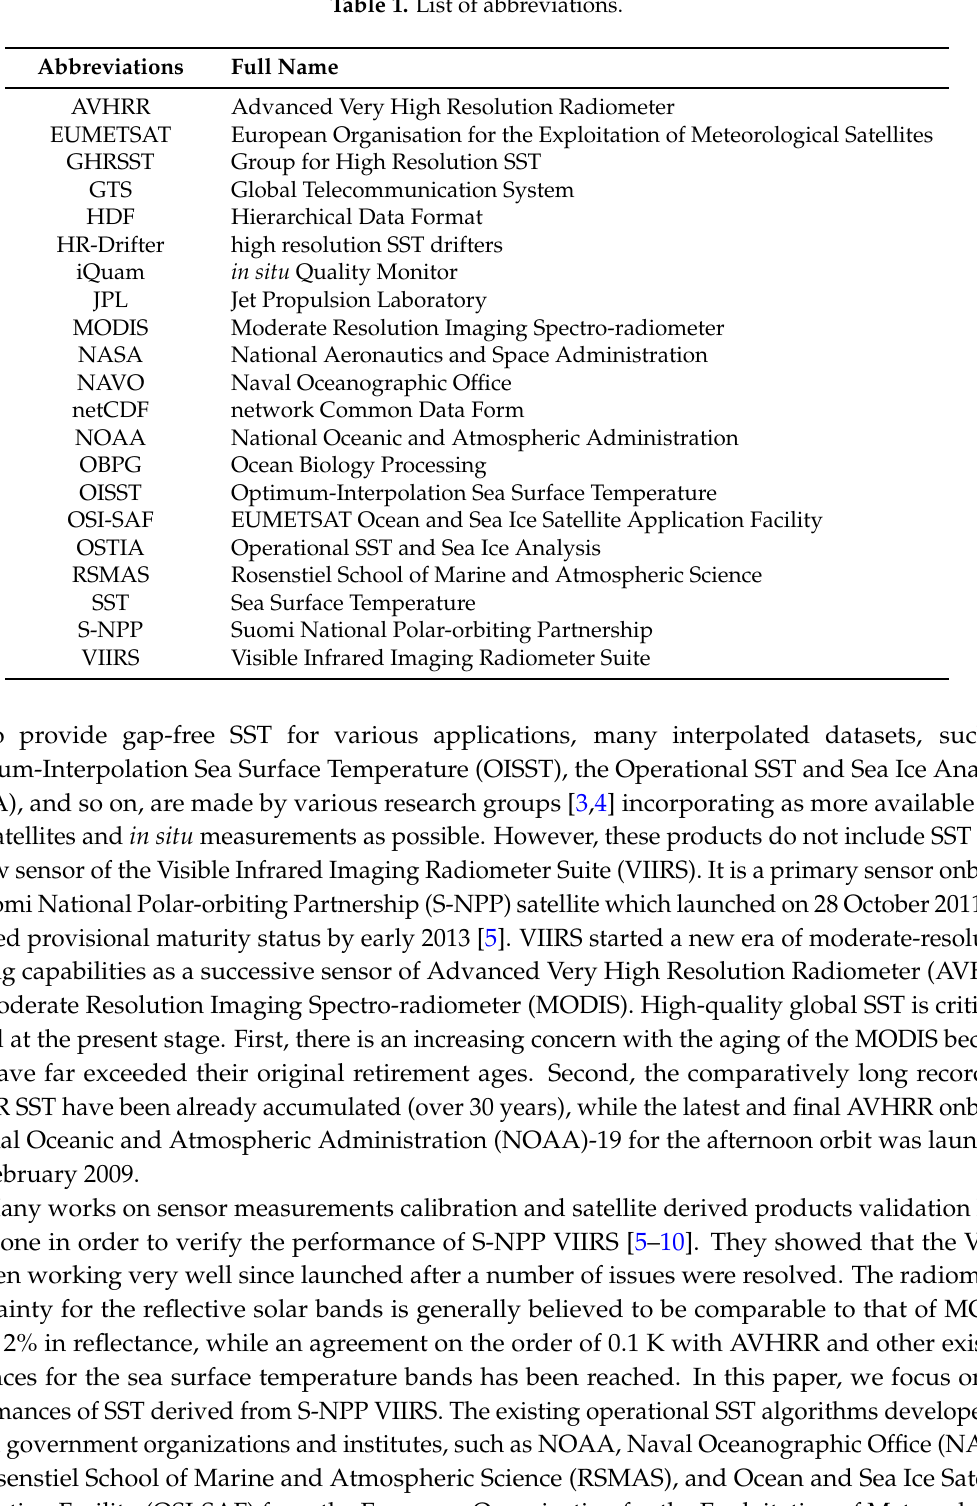
Table 1. List of